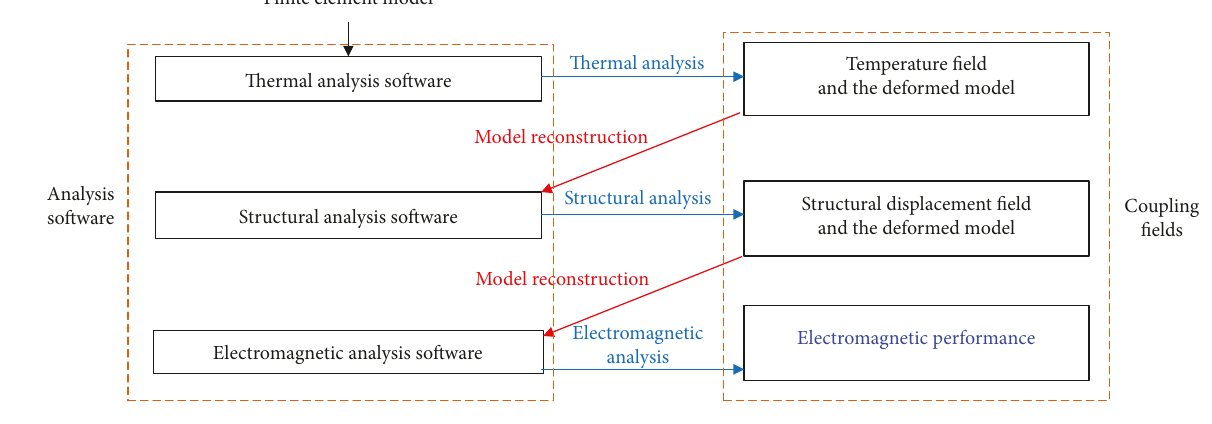
Figure 5: The fl ow chart of the numerical solution.